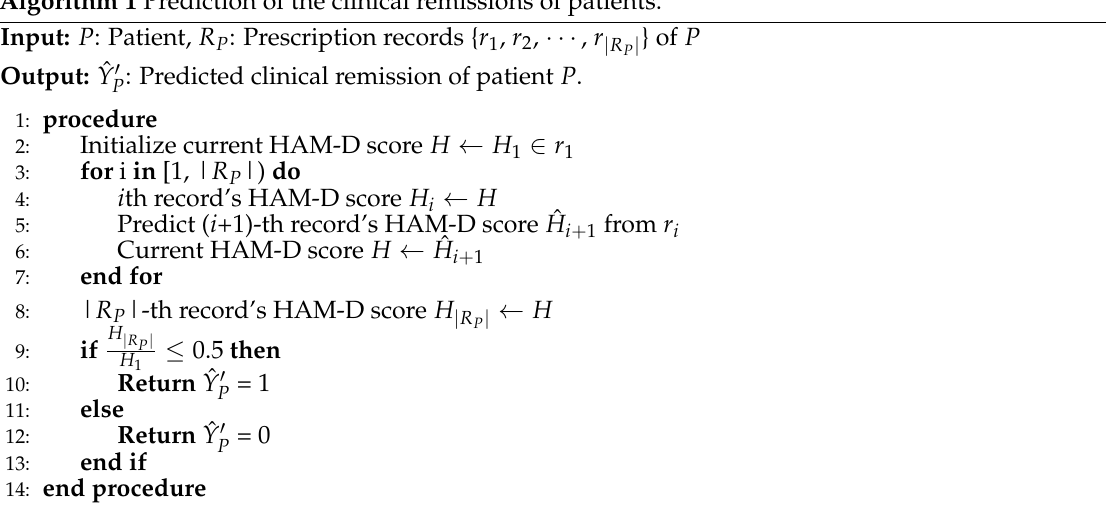
Algorithm 1 Prediction of the clinical remissions of